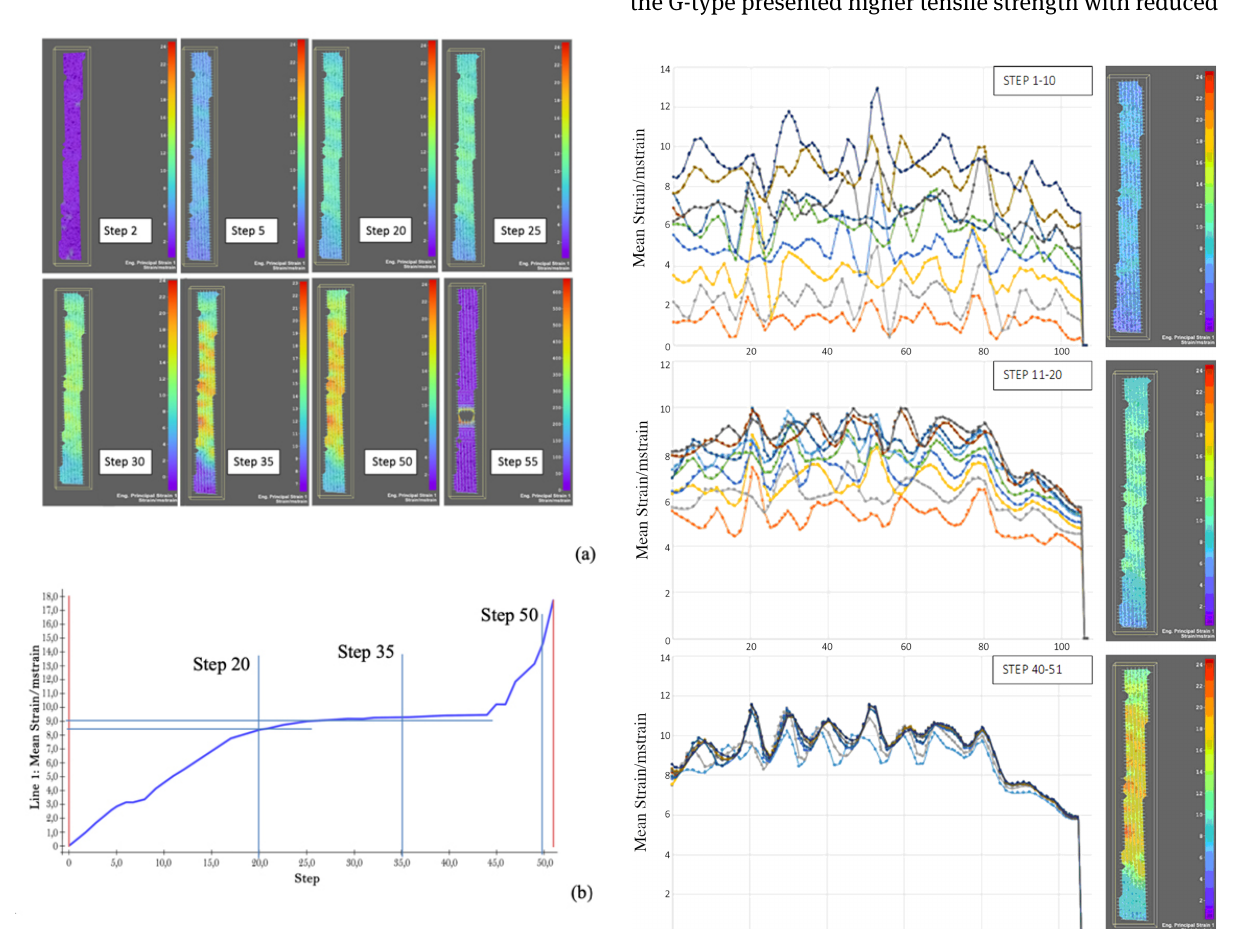
Figure 8: Mean strain versus steps (Time graph). The specimens were subjected to a tensile test until the collapse conditions were reached. Specimen F5(30) Figure 9: Strain vs Time in different steps. Specimen